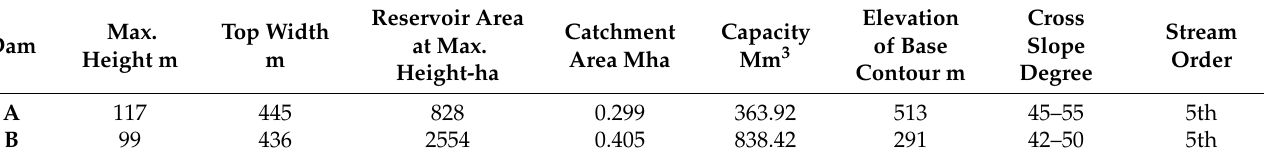
Table 6. Summary of selected suitable sites